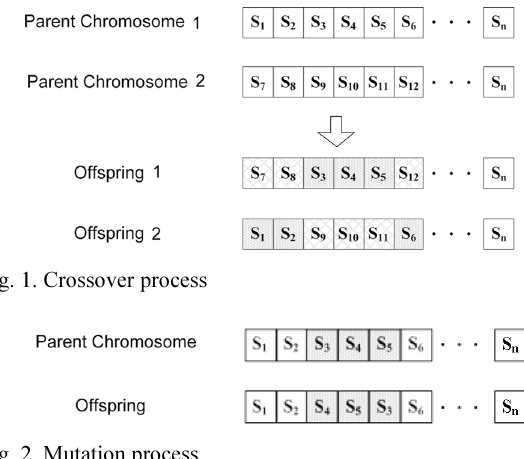
Fig. 2. Mutation process